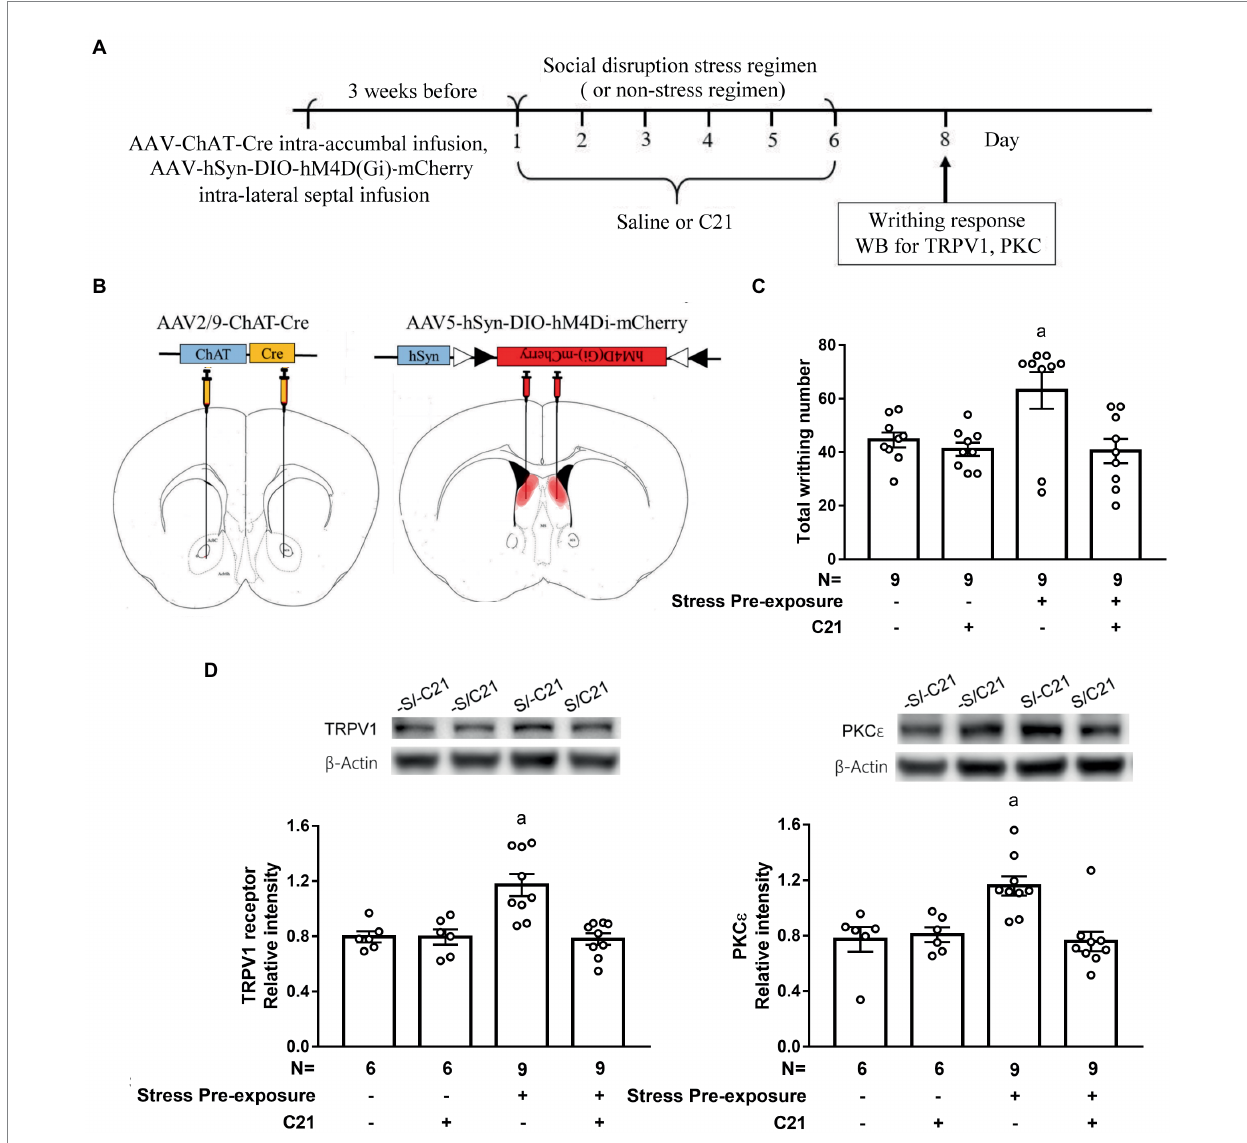
FIGURE 5 Dampening dorsal lateral septal cholinergic activity prevented stress-primed escalations in writhing response and accumbal TRPV1 and PKC ε expression. (A) Timeline for viral infection, C21 treatment, the stress regimen, writhing response test and Western assay. (B) Intra-dorsal lateral septal (0.3 μ l/side, AAV5-hSyn-DIO-hM4Di-mCherry, 2.7 × 10 13 gc/ml) and accumbal viral (0.3 μ l/side, AAV2/9-ChAT-Cre, 2.97 × 10 12 gc/ml) infusions. Overlayed red shaded area indicates all confirmed AAV-mCherry labeling results. and (C) Total acetic acid-induced writhing responses. a Significantly greater than the remaining three groups. (D) Accumbal TRPV1 and PKC ε level. a Significantly greater than the remaining three groups. Graphs show mean ±